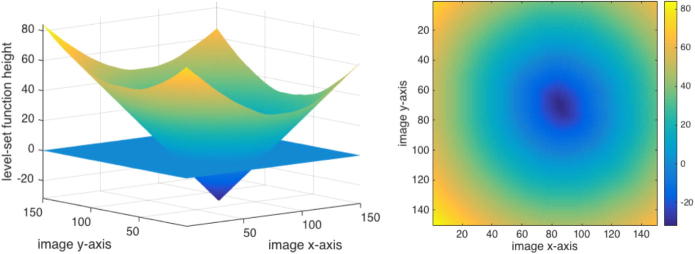
Level-set function.